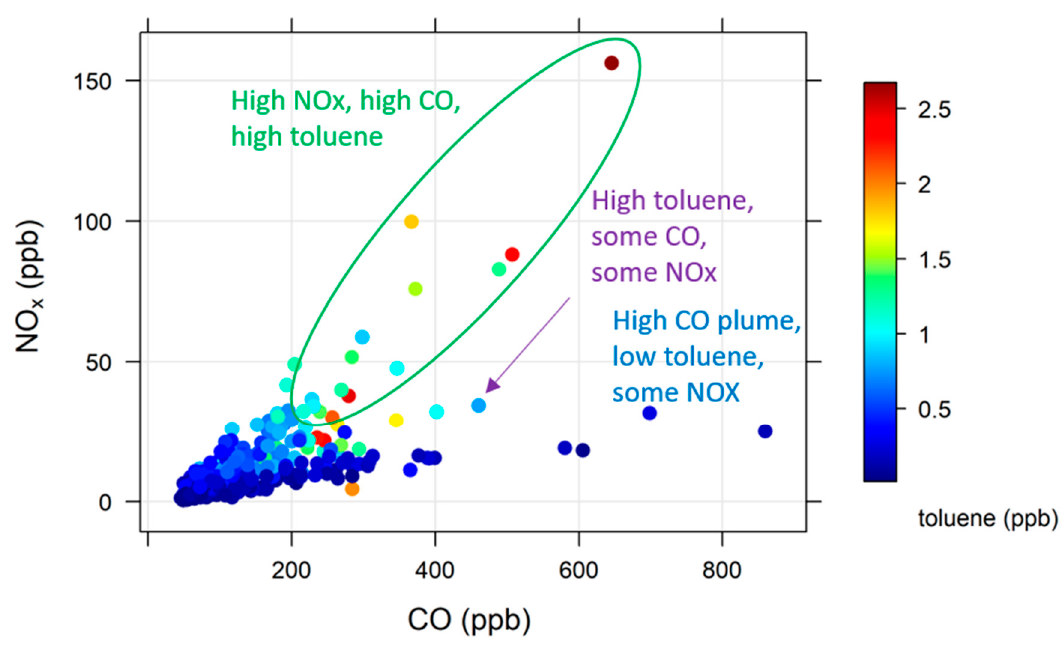
Figure 9. NO x plotted against CO measured at the main MUMBA site. Data points are coloured by toluene concentrations.